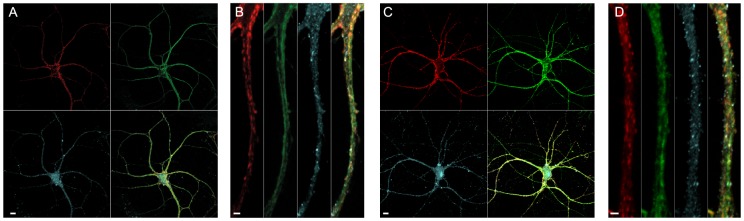
Synaptotagmin-7 staining in cultured hippocampal neurons overlaps with both synaptotagmin-1 and overexpressed SNAP-23/SNAP-25.A: Hippocampal neuron overexpressing EGFP-SNAP25 (green channel, upper right) and stained for syt-1 (red, upper left) and syt-7 (blue, lower left). Scale bar = 10 µm. The lower right panel shows the combined image. B: Close-up image shows that syt-1 is concentrated in spots, which represent presynapses, whereas both EGFP-SNAP25 and syt-7 have a more wide-spread distribution. Scale bar = 2 µm. C: Hippocampal neuron overexpressing EGFP-SNAP23 (green channel, upper right) and stained for syt-1 (red, upper left) and syt-7 (blue, lower left). Scale bar = 10 µm. The combined picture is shown in the lower right panel. D: Close-up image shows a widespread distribution of both EGFP-SNAP-23 and syt-7, which overlaps with, but is not restricted to, the areas stained for syt-1. Scale bar = 2 µm.